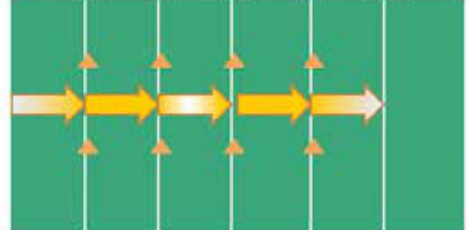
Figure 5-22. Hollow Sprints (10-yard increments shown)